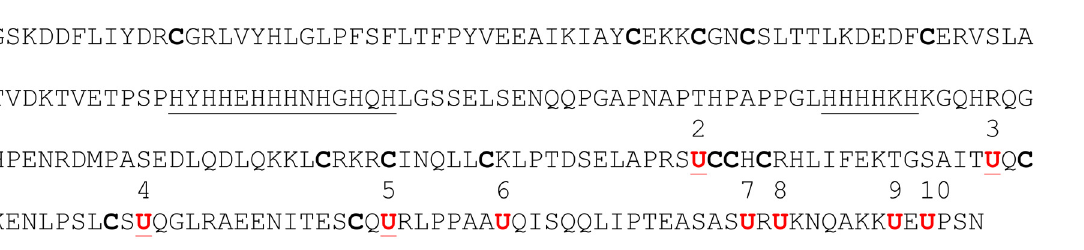
Fig 1. Human SelP sequence. Positions of the ten Sec residues are indicated by numbers and shown in red. Positions of Cys residues are highlighted in bold. Natural His-rich segments, which allow affinity isolation of human SelP, are